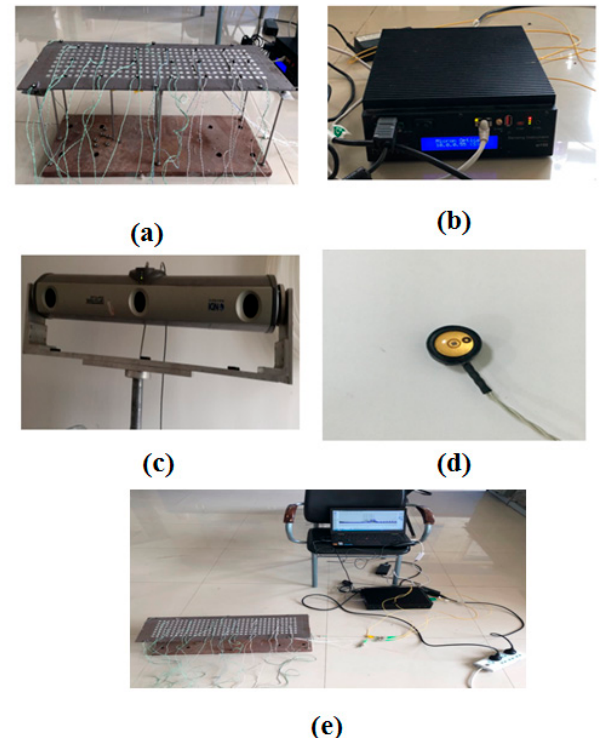
Figure 5. The measurement system; ( a ) fixed device; ( b ) Fiber Bragg Grating (FBG) demodulator; ( c ) Northern Digital Incorporation (NDI); ( d ) marker; ( e ) Measurement process.